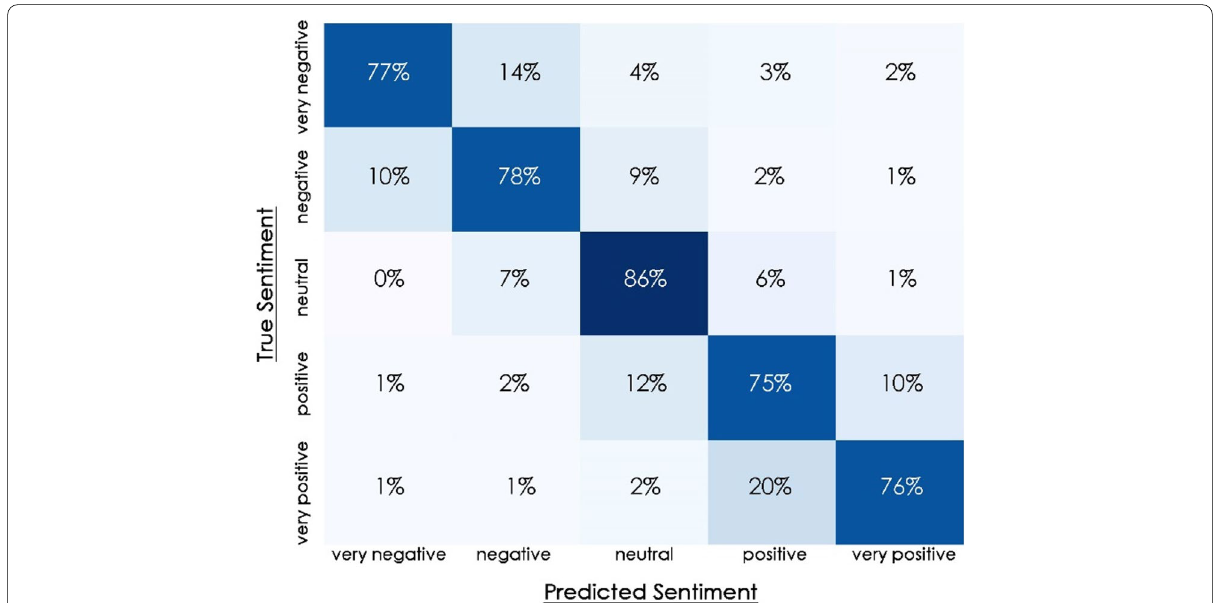
Fig. 2 The confusion matrix. Source: